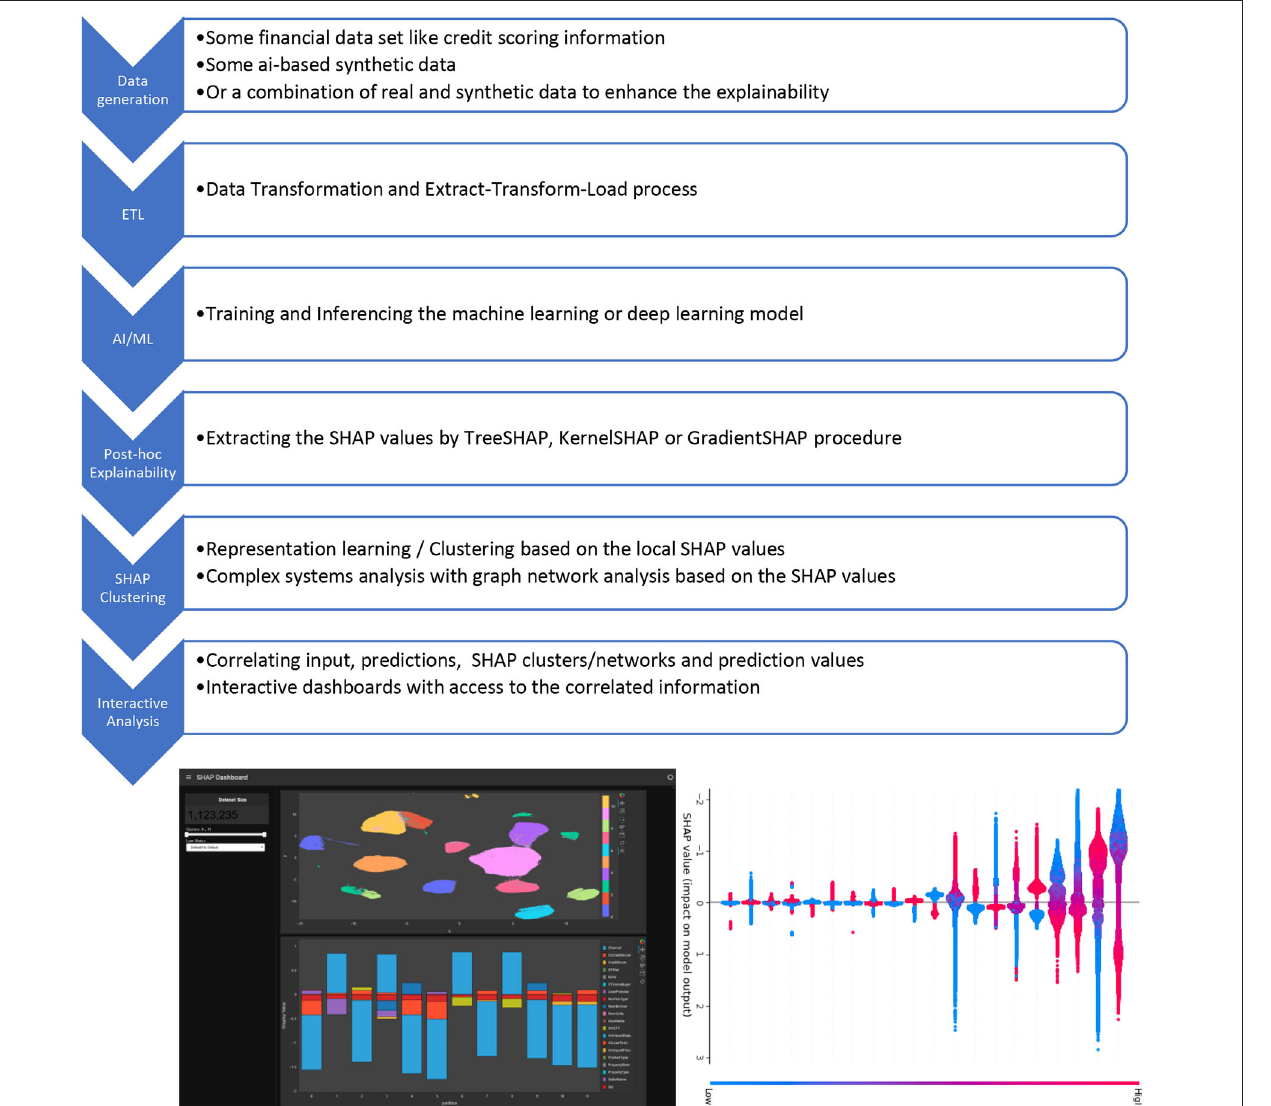
FIGURE 2 | Description of the end-to-end workflow for an application to interactively analyse post-hoc explainable AI information. The dashboards have been produced with